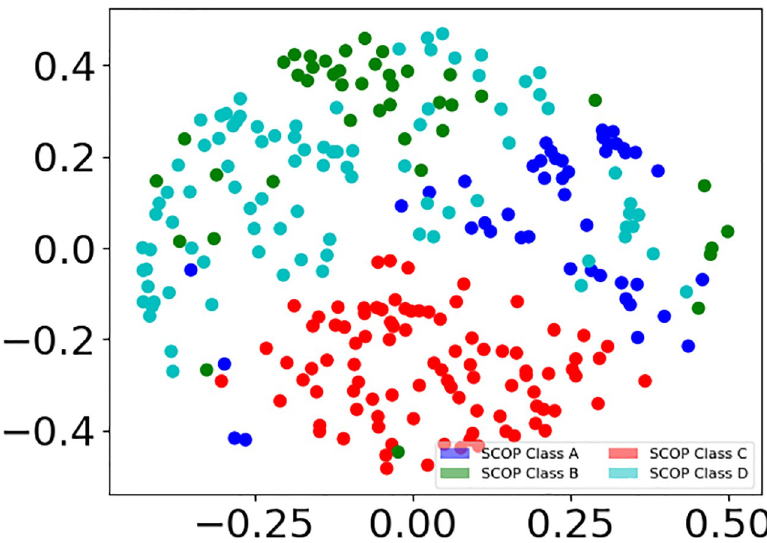
Fig 4. MDS scatter plot based on median MCPSC scores. Domains are colored according to their SCOP class (Level